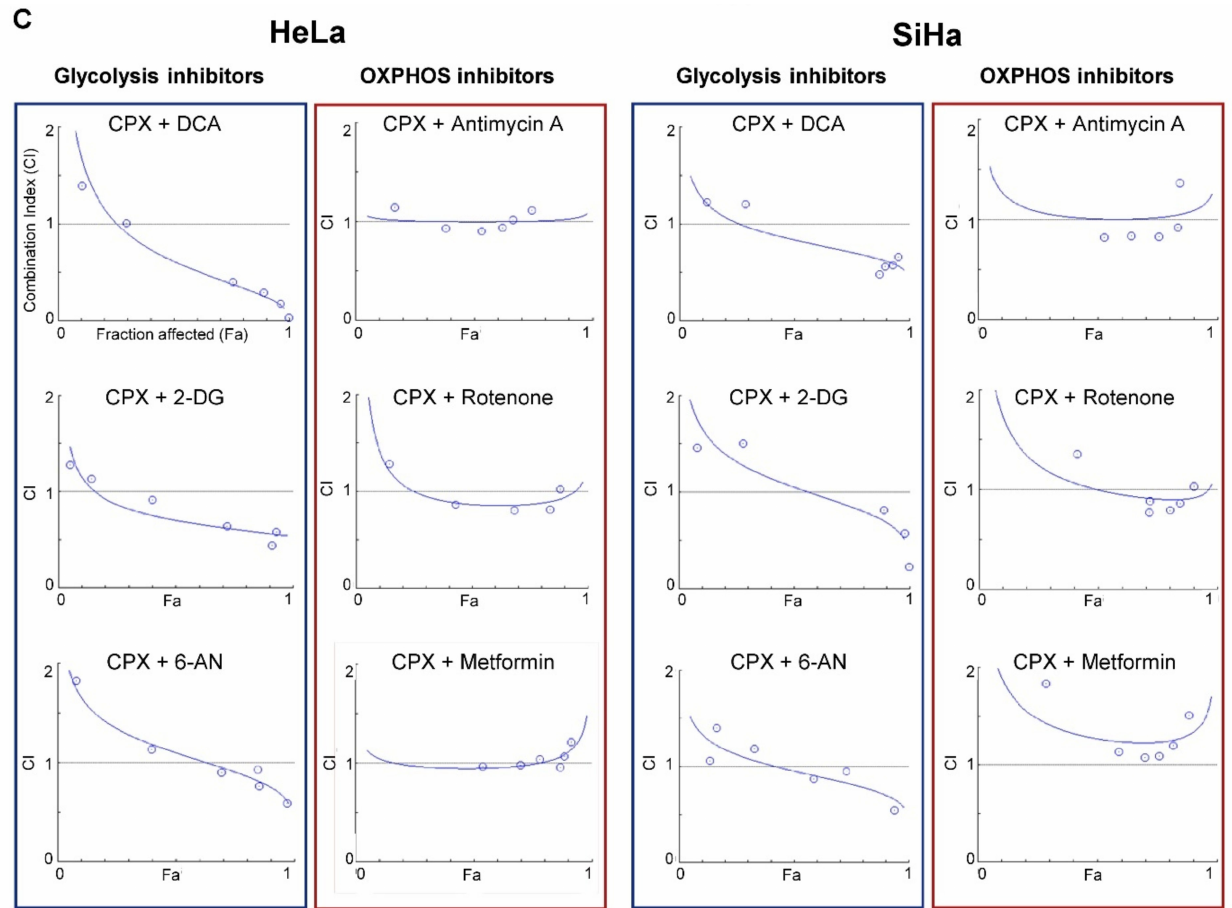
Figure 7. CPX acts synergistically with glycolysis inhibitors. ( A ) Immunoblot analyses of PARP, cl-PARP, and HPV18 E7 levels in HeLa cells after 48 h treatment with CPX and DCA as indicated. β -Actin: loading control. ( B ) Growth curves of HeLa mKate2 cells treated with the indicated doses of CPX and DCA. Red object count indicating viable cells was assessed every 4 h over a period of 144 h using the IncuCyte ® S3 live-cell imaging system. ( C ) HeLa mKate2 or SiHa mKate2 cells were treated with varying doses of CPX and the indicated OXPHOS or glycolysis inhibitors with a constant drug ratio over the course of 5 days. Every 4 h, viable cell count was assessed. Fraction affected (Fa) vs. combination index (CI) plots were created with the CompuSyn software, based on viable cell count. Data from one representative experiment each are illustrated. All experiments depicted in Figure 7 were performed under a concentration of 1 g/L